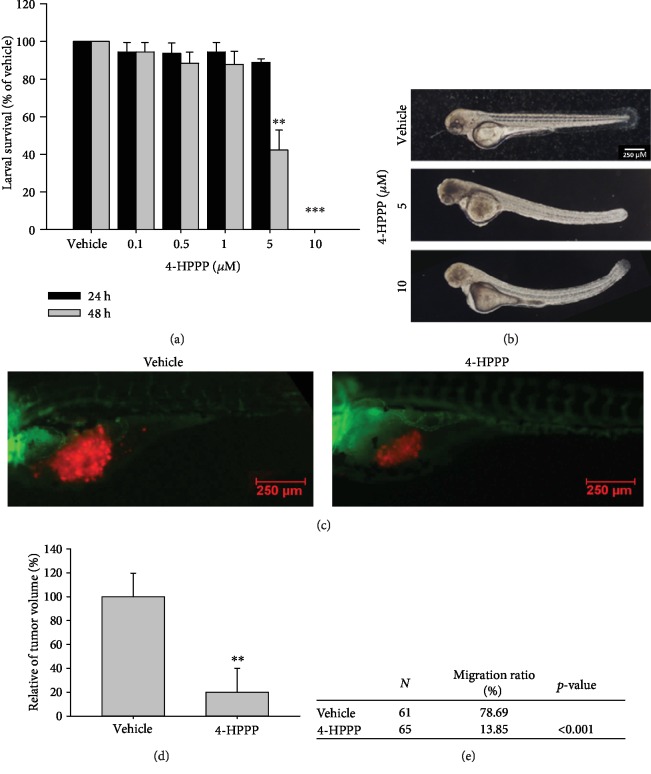
Effect of 4-HPPP on zebrafish-based xenografted NSCLC cells. (a) Survival rate of zebrafish larvae following 4-HPPP exposure. (b) The results showed that 5 μM and 10 μM 4-HPPP caused body axis bending and edema in zebrafish larvae, indicating that a high concentration of 4-HPPP could cause deformation and toxicity toward zebrafish larvae. (c) The motility of xenografted H1299 cells in the yolk sac of zebrafish larvae. The intensity of red fluorescence is proportional to the xenograft tumor size. For each group, the sample size of larvae (N) > 60. (d, e) Quantitative analysis of (c). The data are presented as the mean ± S.D. ∗∗p < 0.05 and ∗∗∗p < 0.001 against vehicle control. (e) The statistical analysis of the migration ability of xenografted H1299 cells using Fisher's exact test.